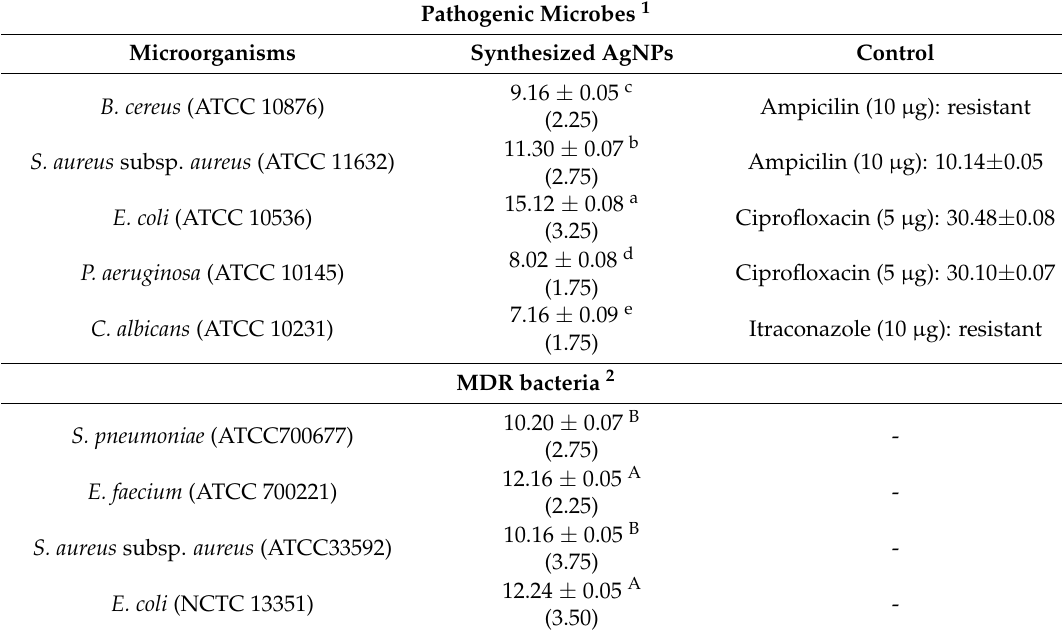
Table 3. ZOI (mm) and MIC ( µ g/mL) values of the synthesized AgNPs against pathogenic microbes and MDR bacteria.